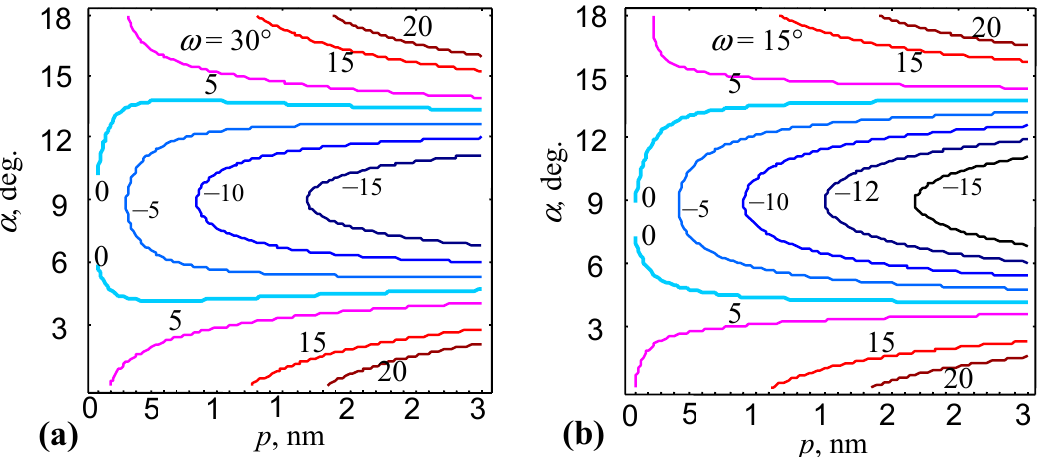
Figure 2. Maps of the energy difference ∆ W ( p , α ), for various values the strength ω of the disclination quadrupole ( a ) ω = 30° and ( b ) ω = 15°. The values of ∆ W are given in units of eV/nm.